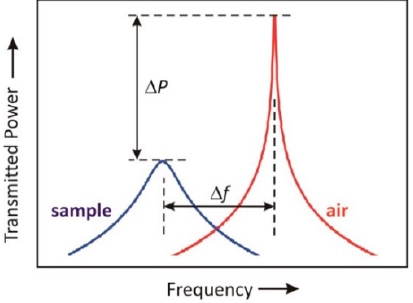
Figure 8. Microwave resonator perturbation diagram between air and sample measurement.